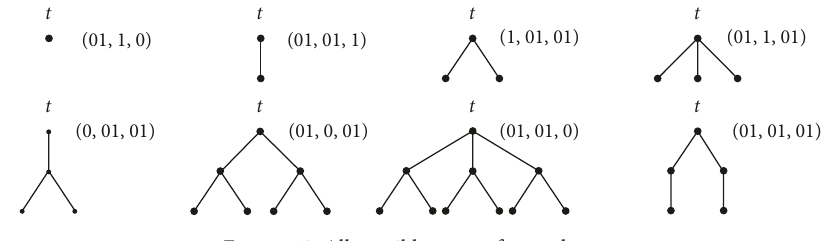
Figure 12: All possible types of rooted trees. Table 1: The result table of types of a new rooted tree derived by doing an Add Into Operation on a rooted tree 𝑇 1 which has the type in the first left column to a rooted tree 𝑇 2 which has the type in the first top